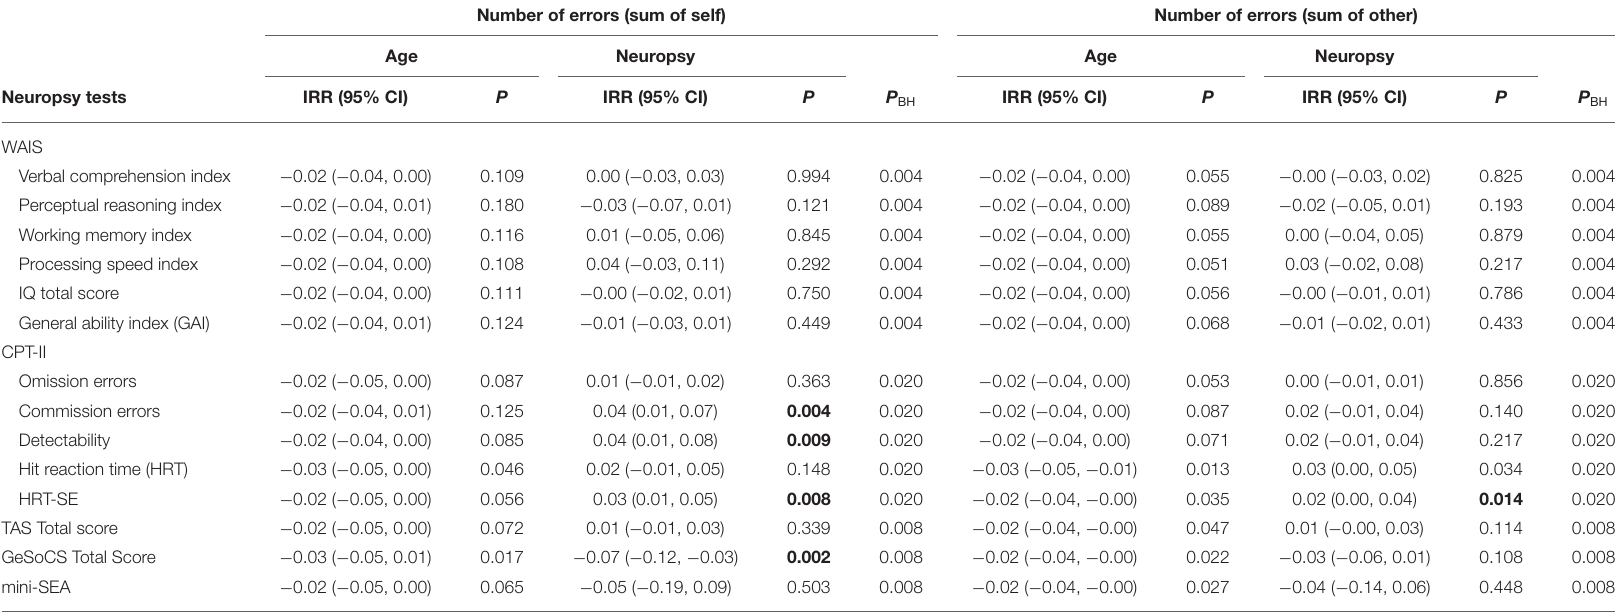
TABLE 3 | Association of neuropsychological tests (independent variables) with the sum of the number of errors across different conditions (self or other) using negative binomial regressions, adjusted for age. Number of errors (sum of self) Number of errors (sum of other) Age